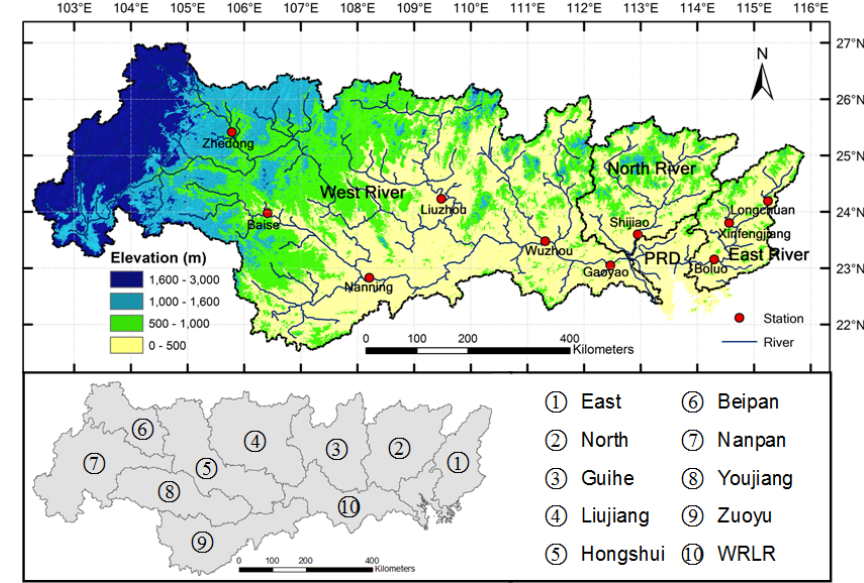
Fig. 1. The Pearl River basin in southern China, gauge stations, and 10 sub-basins (after Niu, 2013).